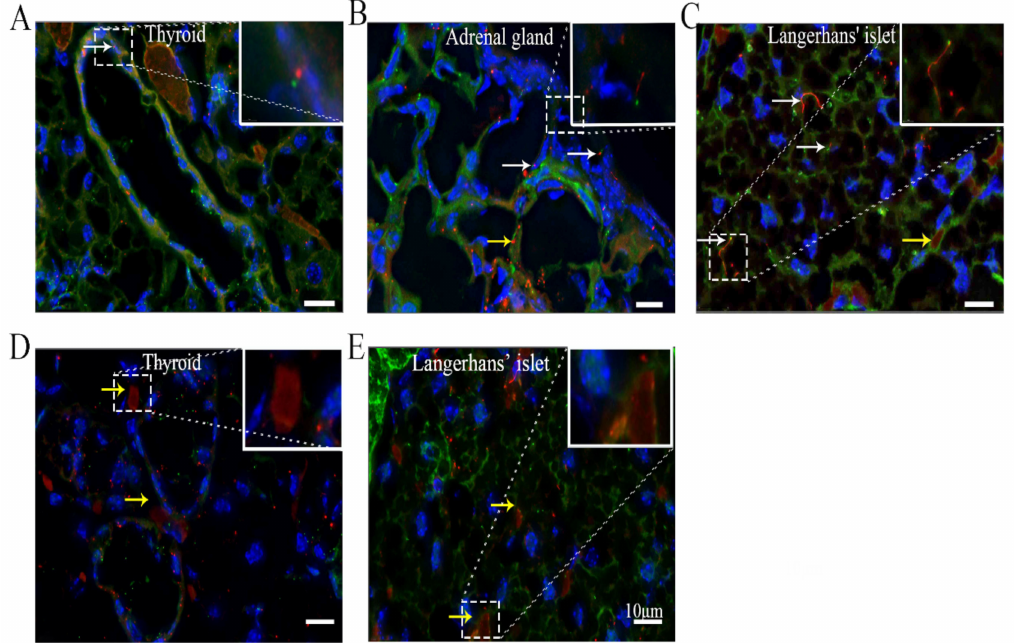
Figure 6. ARL13B+ inclusions are present in the thyroid and islets of Langerhans. ( A ) Thyroid, ( B ) adrenal gland, ( C ) islets of Langerhans, ( D ) thyroid cells with ARL13B-mCherry+ inclusions ( E ) cells in islets of Langerhans with ARL13B-mCherry+ inclusions. White arrow, cilium with an axoneme and basal body. Yellow arrow, cell with ARL13B-mCherry+ inclusions or particles. Blue, DAPI. Green, Centrin2-GFP. Red, ARL13B-mCherry. Scale bar, 10 µ